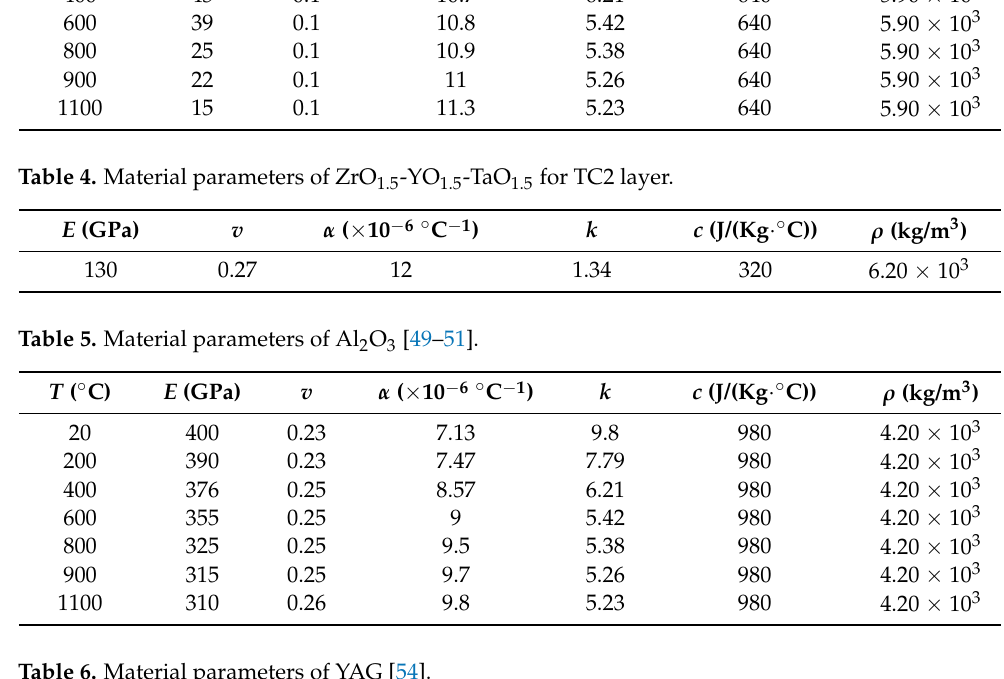
Table 6. Material parameters of YAG